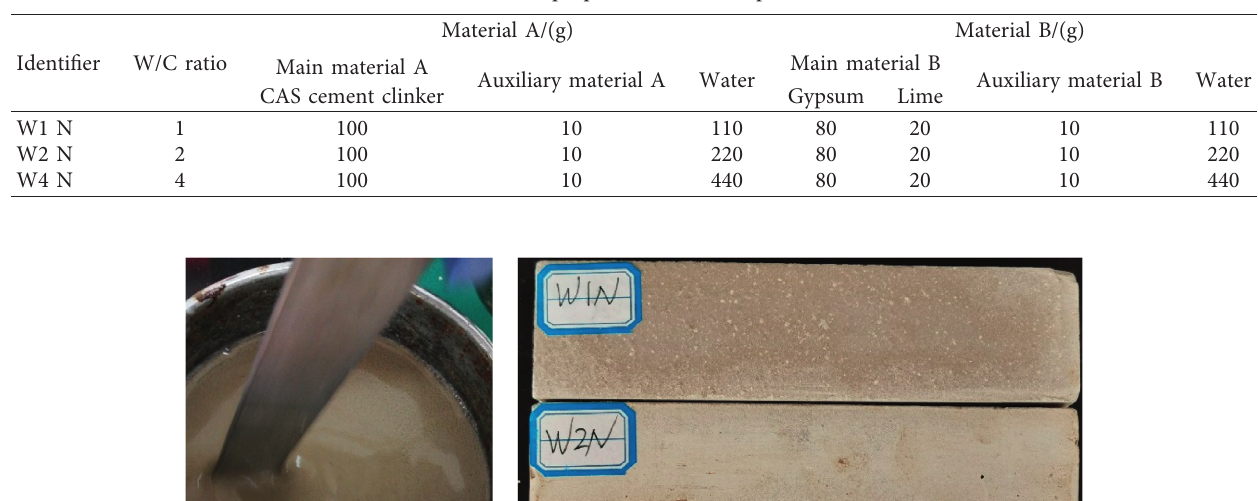
Figure 1: Raw material component of NCG material. Table 1: Mix proportions of NCG specimens.